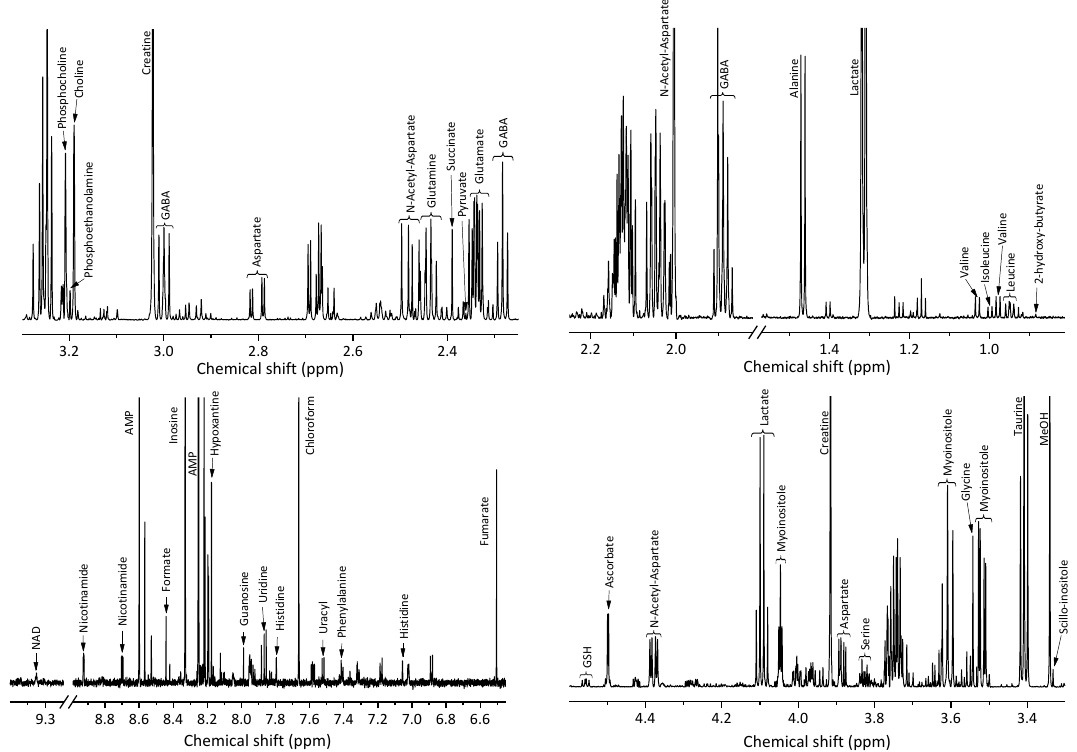
Figure 1. Typical NMR spectrum of brain tissue of the CD-1 mouse line with metabolite annotation. Table 1. Metabolite concentrations (nmol/g) in the brain tissue of animals from groups A and B. The comparison of group s was performed by Student’s t -test with the estimation of the test power. Without Blood With Blood M ± S.D. M ± S.D.